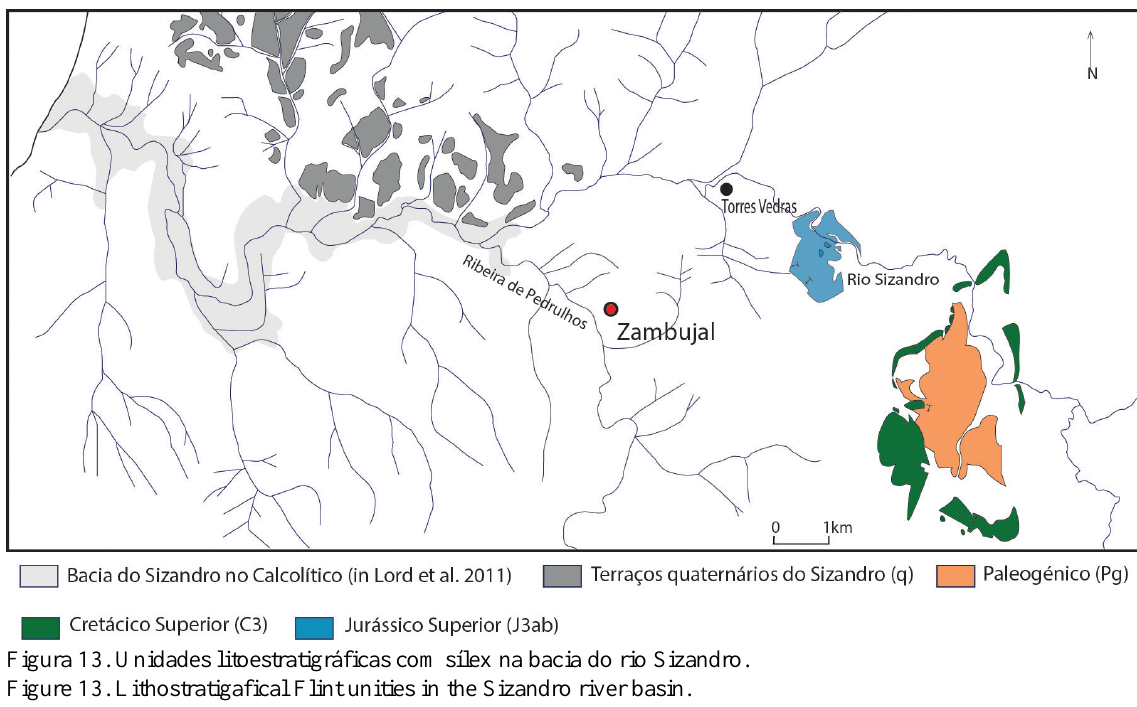
Figura 13. Unidades litoestratigráficas com sílex na bacia do rio Sizandro. Figure 13. Lithostratigafical Flint unities in the Sizandro river